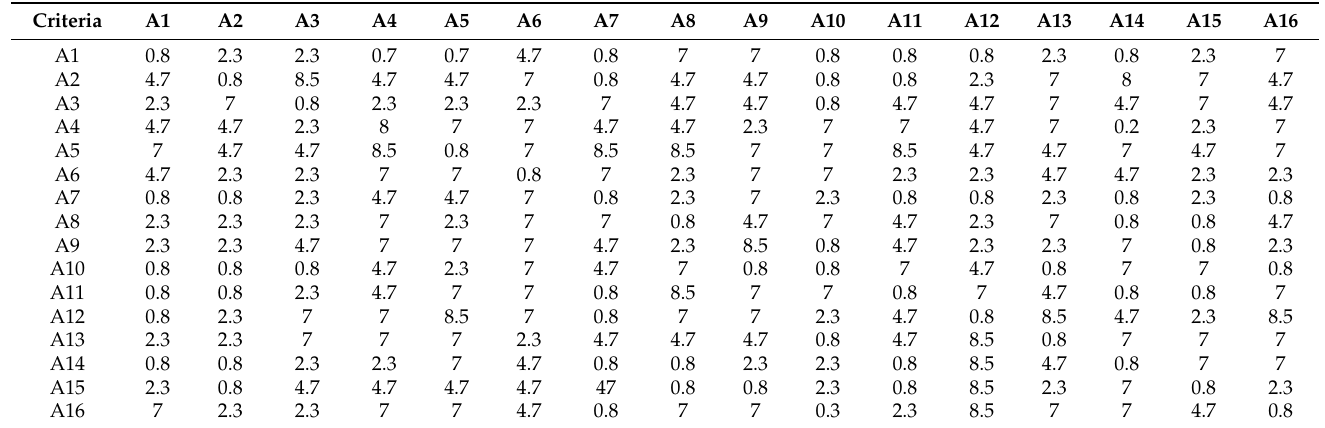
Table 5. The normalized direct-relation matrix X —the TBL’s perspective ( × 10 − 2 ).